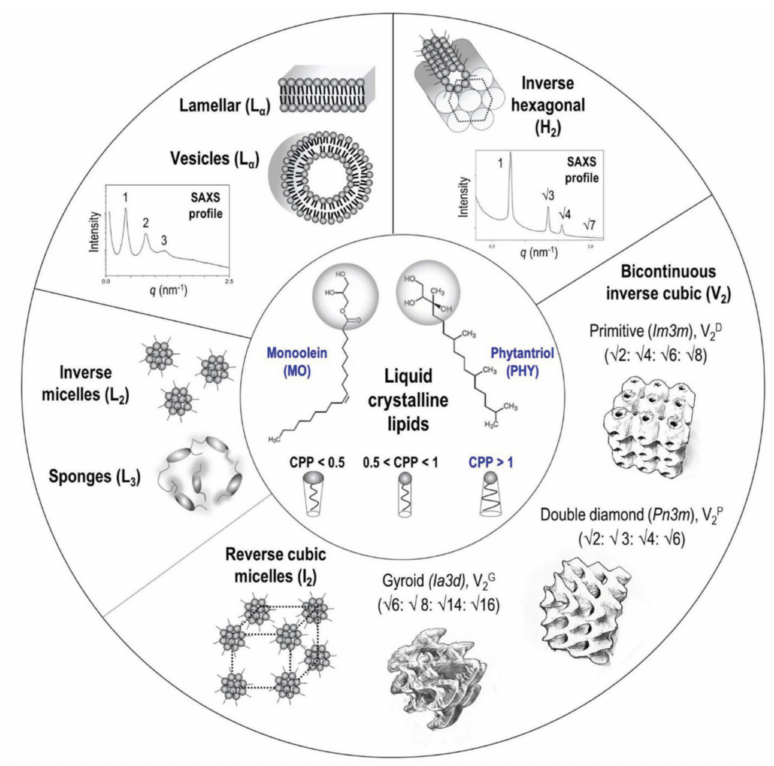
Figure 1. Structures of commonly encountered mesophases produced by the self-assembly of lyotropic lipids with varying critical packing parameters (CPP). The liquid crystalline phases are identified based on their characteristic di ff raction spacing ratios determined by the small-angle X-ray scattering (SAXS) technique (reproduced from [7], with permission from Wiley-VCH Verlag GmbH & Co.,